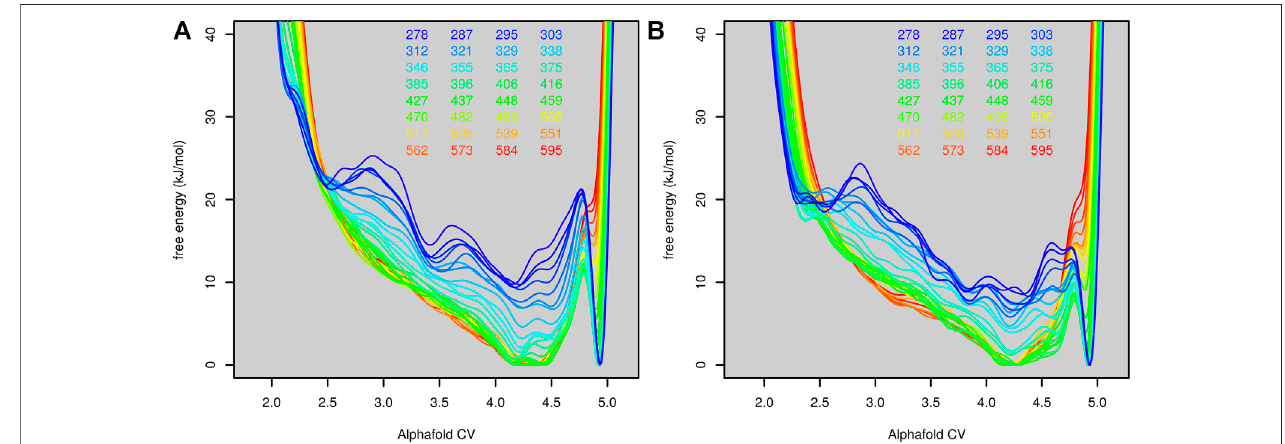
FIGURE 4 | Free-energy surfaces of Trp-cage (as functions of AlphaFold-based CV) calculated at different temperatures in the run stared from the folded ( (A) , the fi rst run) and unfolded ( (B) , the second run) state.